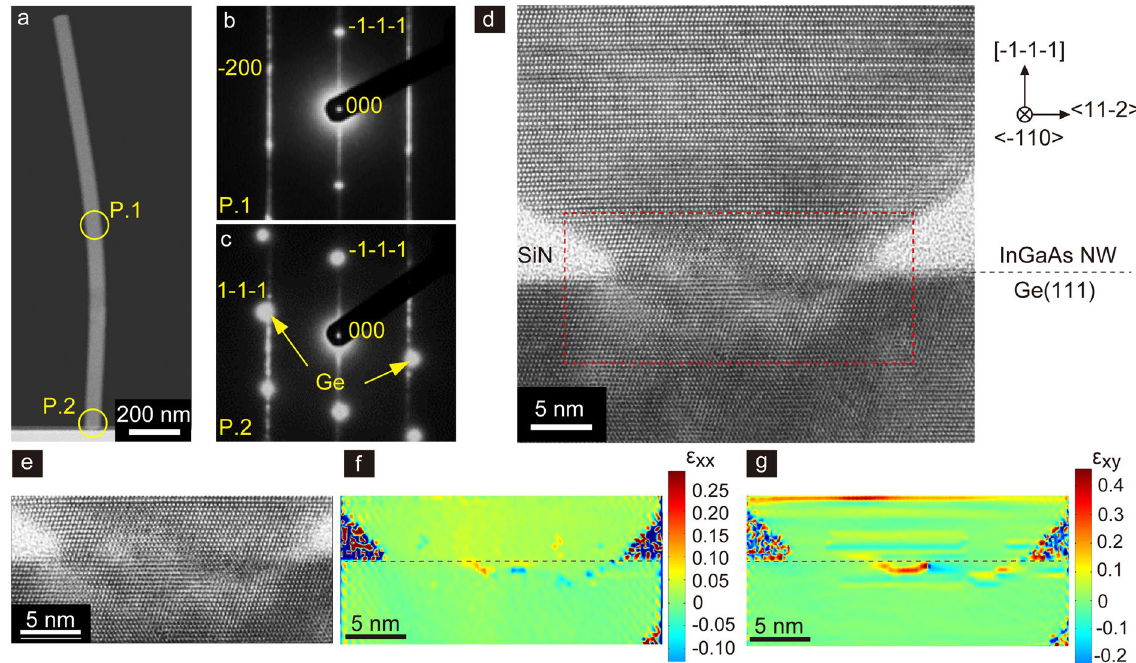
Figure 3. Crystal structure of the InxGa1 − xAs NWs on Ge and the InxGa1 − xAs NW/Ge heterojunction. ( a ) Low magnification TEM image showing In 0.68 Ga 0.32 As NW on p-Ge(111). ( b ) Selected-area diffraction (SAED) pattern of In0.68Ga0.32As NW denoted as P.1 in ( a,c ) Adjacent In 0.68 Ga 0.32 As NW/Ge denoted as P.2 in ( b ). ( d ) TEM image depicting the InGaAs NW/Ge(111). ( e ) Magnified TEM image of red dashed square in ( d ). Strain mappings estimated from the ( e ), ( f ) ɛ xx mapping and ( g ) ɛ xy